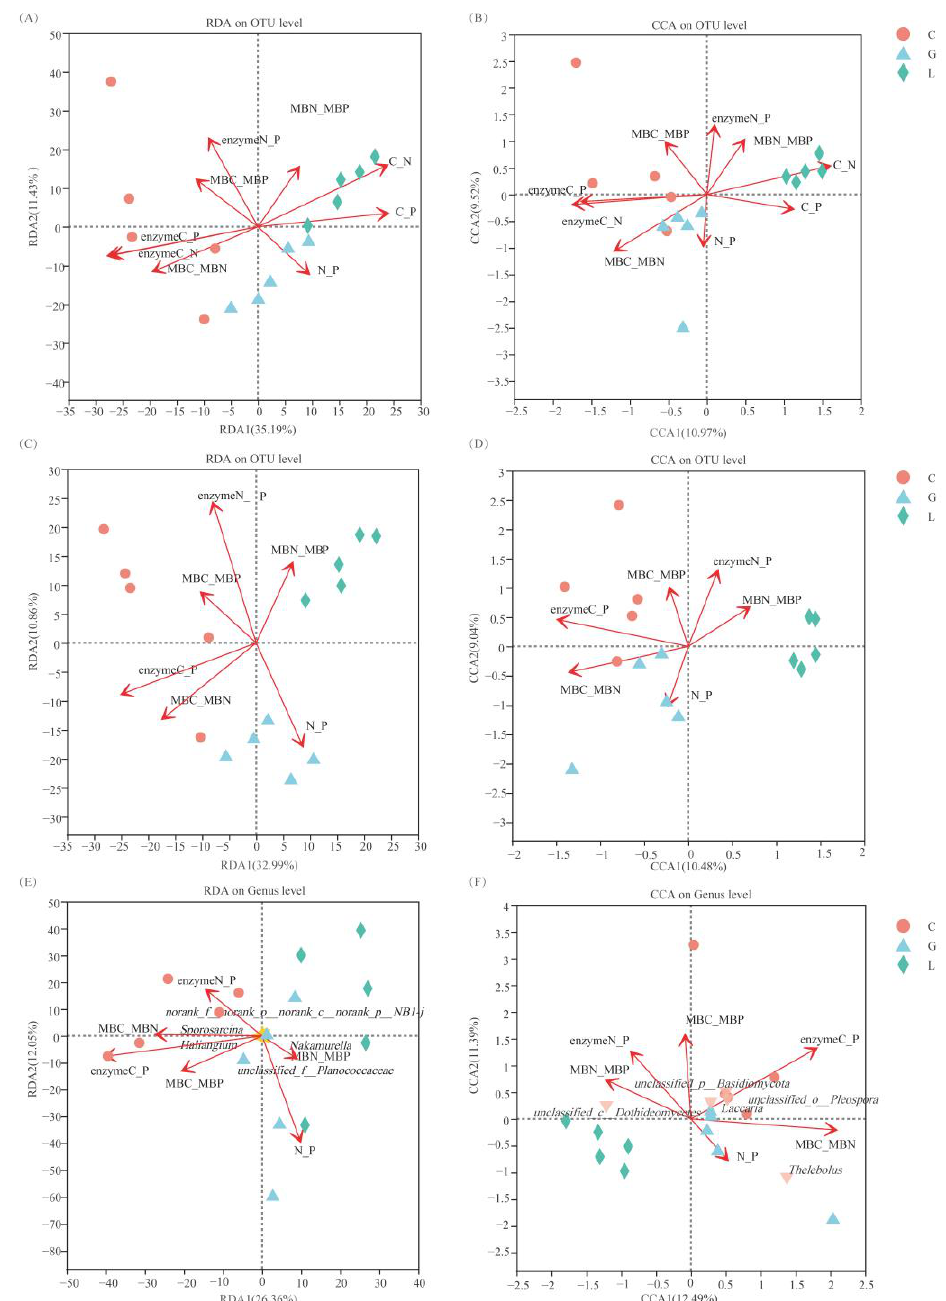
Figure 8. ( A , B ) The stoichiometric effects of soil, soil microorganisms and soil enzymes on bacterial ( A ) and fungal ( B ) communities and their interactions. ( C , D ) The stoichiometric effects and interac- tions of soil, soil microorganisms and soil enzymes on bacterial ( C ) and fungal ( D ) communities after VIF variance expansion factor screening. ( E , F ) Effects and interactions of stoichiometry of soil, soil microorganisms and soil enzymes on dominant genus (top5) of bacteria ( E ) and fungi ( F ) after VIF variance expansion factor screening for three planting subtypes.